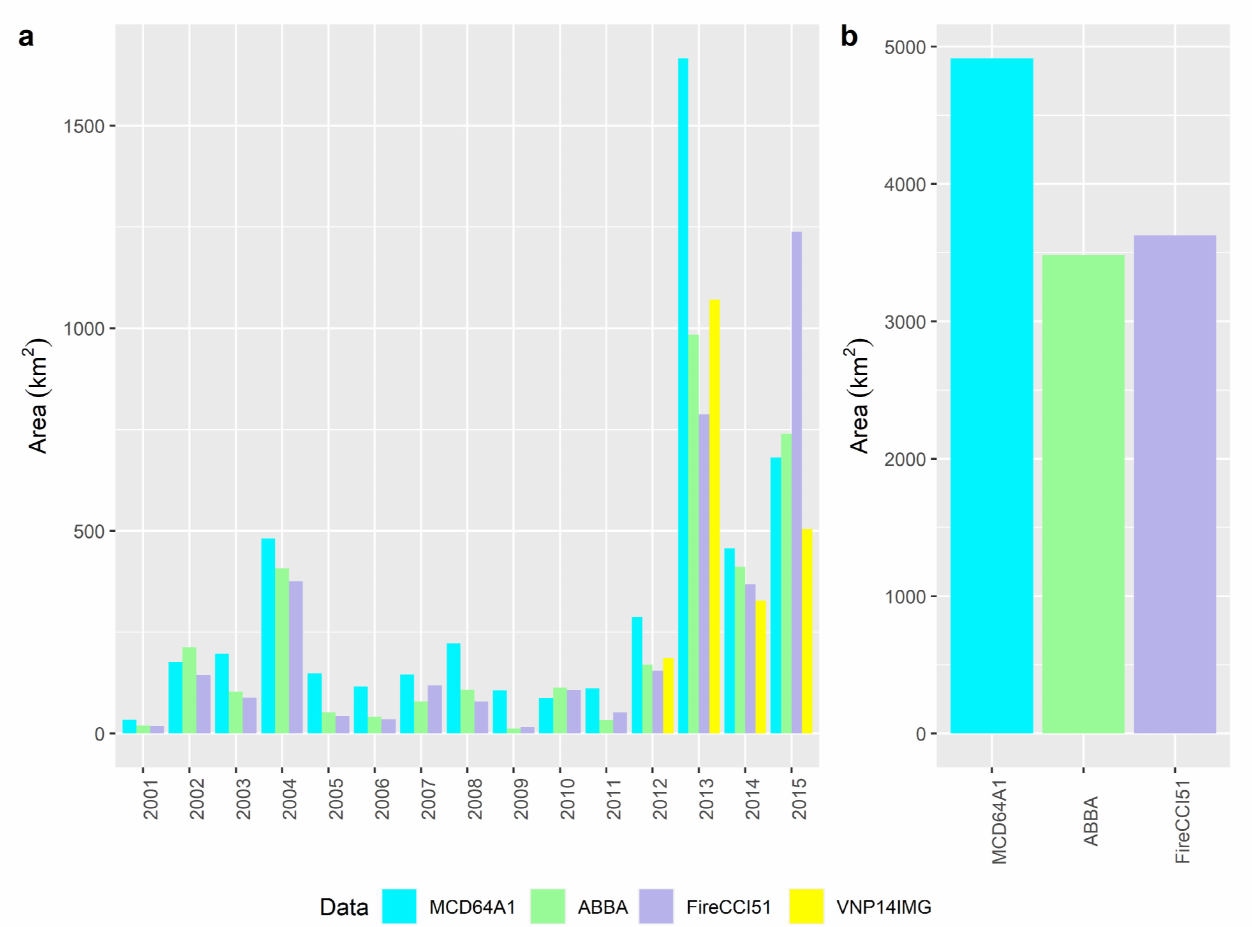
Figure 8. Comparisons of ( a ) annual total area and ( b ) grand total area of burned areas, as mapped by the MCD64A1, ABBA, FireCCI51 products, that are outside the buffer zones created based on the CNFDB burned areas. In ( a ), the total area of 500 m pixels that have VNP14IMG active fire detections and outside the buffer zones is compared with the three burned area products as